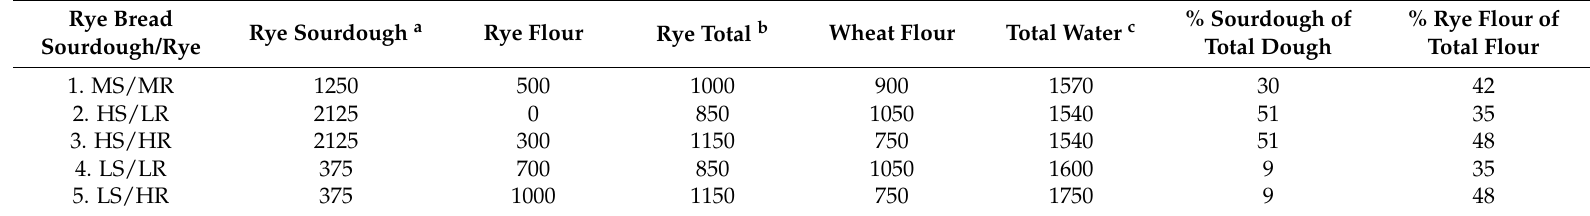
Table 1. Rye bread recipes and